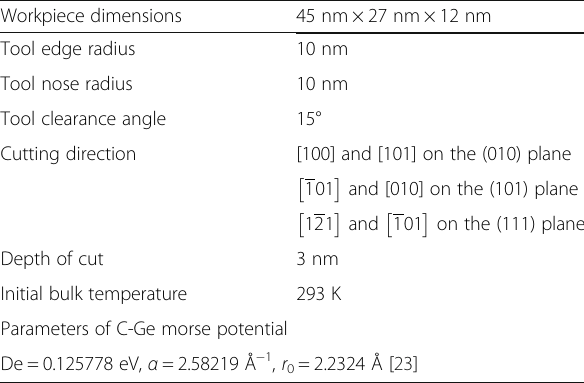
Table 1 Model condition and simulation parameters Workpiece